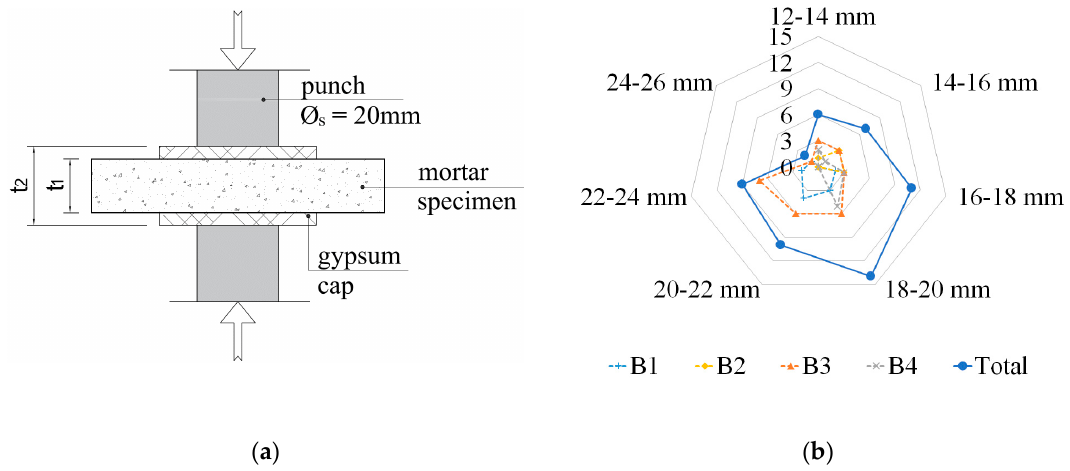
Figure 5. DPT tests: ( a ) the specimen loading scheme; ( b ) the specimen population structure depending on thickness t 1 .